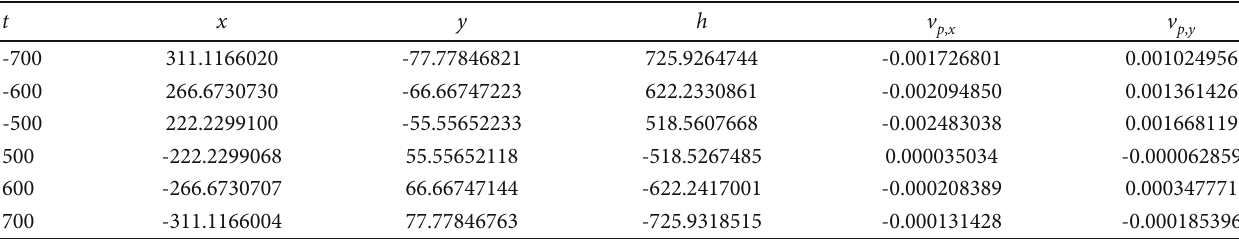
Table 2: Test of the fi tted equation.